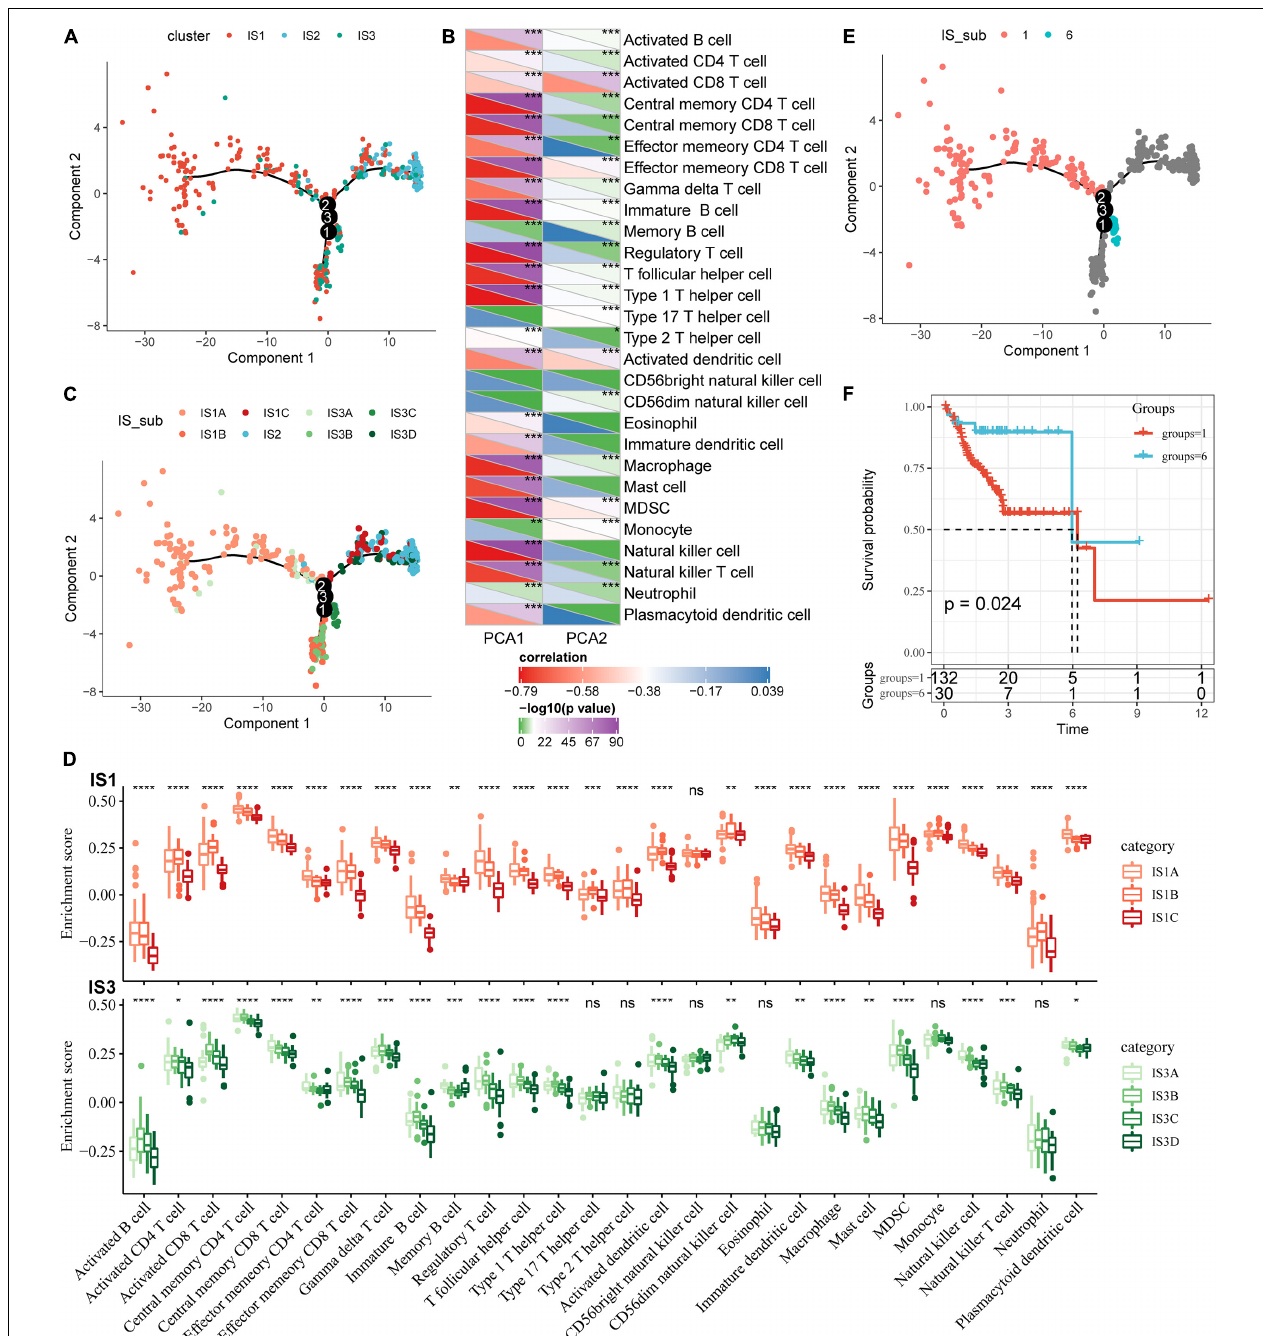
FIGURE 7 | Immune landscape of COAD. (A) The immune landscape in colon cancer, where each point represents a sample, different colors represent different molecular subtypes, the horizontal axis represents the first principal component, and the vertical axis represents the second principal component; (B) The correlation heat map between the two principal components and 28 types of immune cells; (C) The immune landscape and molecular subgroups of three immune subtypes in colon cancer; (D) The immune landscape in colon cancer and samples from two different locations; (E) The immune landscape in colon cancer; (F) The prognosis of samples at different locations in the immune landscape of colon cancer is different. * P < 0.05, ** P < 0.01, *** P < 0.001, and **** P < 0.0001.